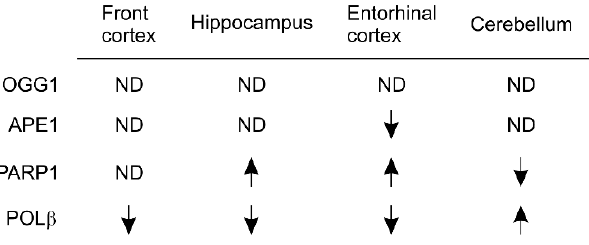
Figure 4. Summary of expression of the indicated BER genes in AD brains compared to age ‐ matched controls. Arrows indicate upregulation and downregulation respectively. APE ‐ 1: AP (apurine/apirimidine) endonuclease 1; ND: no differences; OGG1: DNA glycosylase; PARP1: poly(ADP) ribose polymerase 1; and POL β : DNA polymerase β